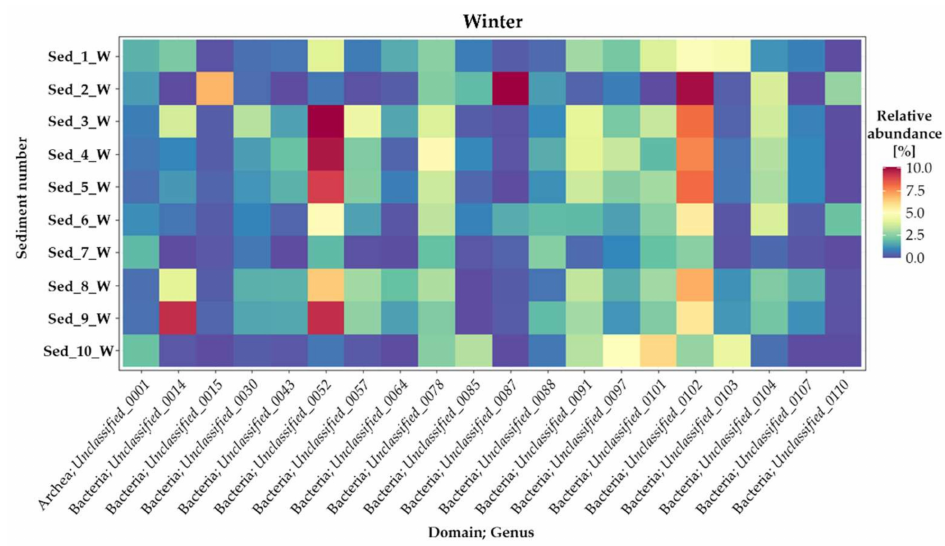
Figure A1. Heat maps illustrating seasonal changes in the unclassified genera of bacteria in the selected location of the bottom sediments in Cardinal Pond (1–10 Sed—sediment sampling points; Sp—spring, Su—summer, A—autumn,